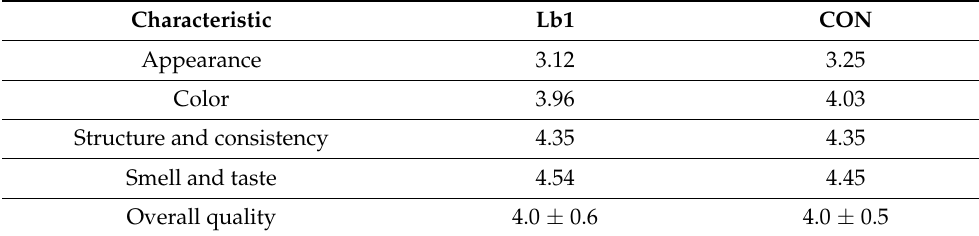
Table 6. Sensory evaluation of the non-dairy ice cream dessert (n =